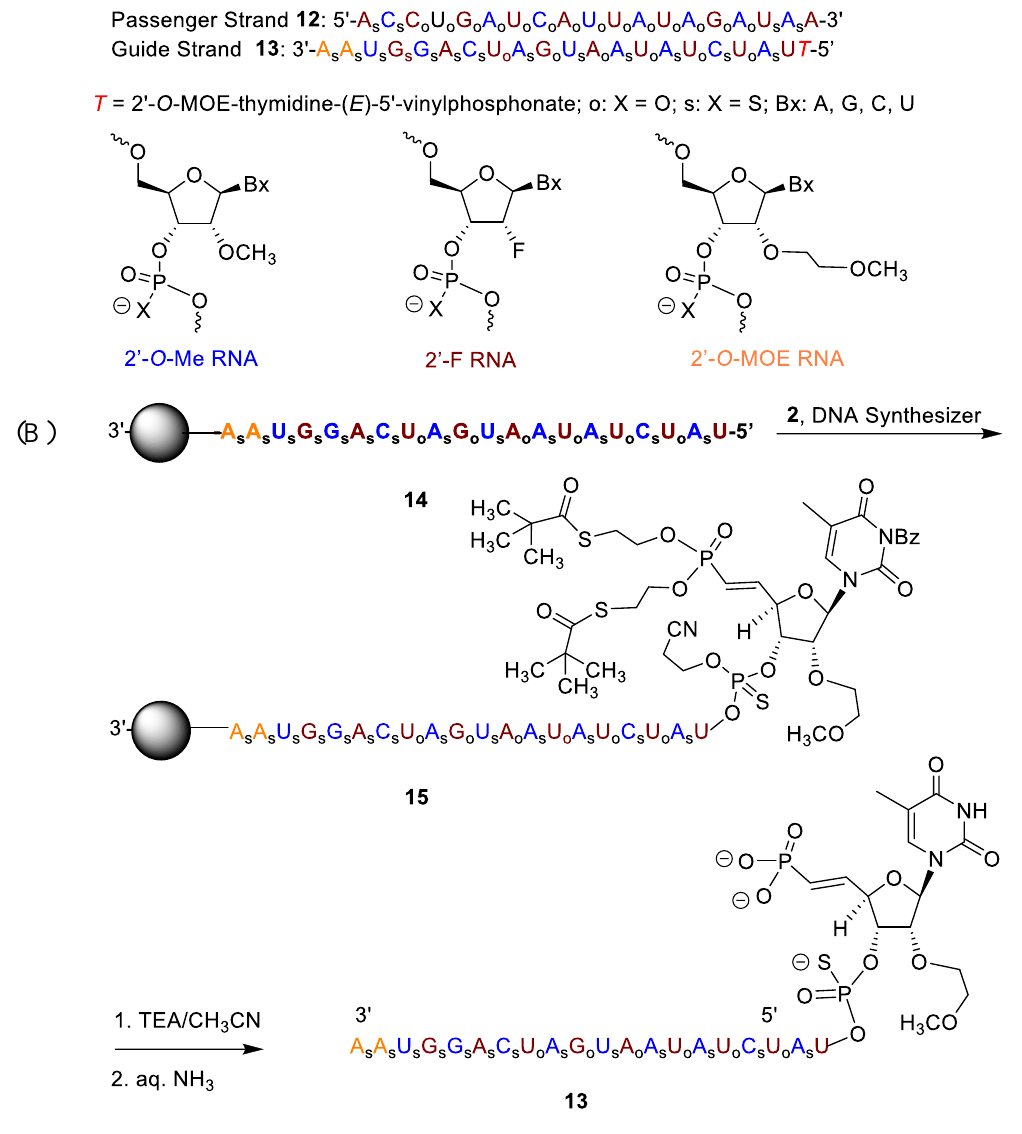
Figure 2. ( A ) siRNA 12 / 13 targeting murine phosphate and tensin homolog (PTEN) containing an alternating 2 ′ -F/2 ′ - O -Me motif with a ( E )-5 ′ -VP-2 ′ - O -MOE T; ( B ) Solid-phase synthesis of siRNA guide strand 13 using bis( t Bu-SATE)-protected phosphoramidite 2 .